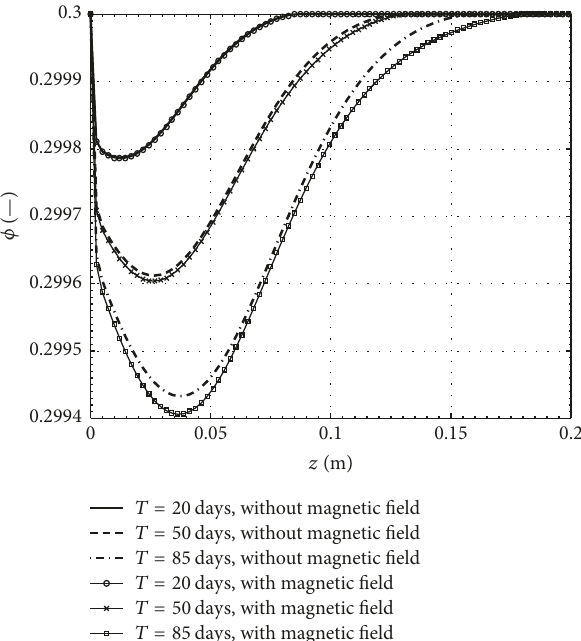
Figure 8: Permeability variation against core length with and without magnetic field effect for various values of imbibition time: magnet is placed on the right side of the core.